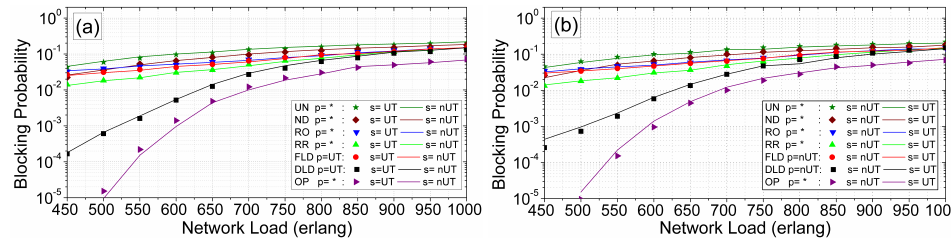
Figure 7. Blocking probability as a function of the total load in EuroNet topology using 504 regenera- tors and traffic: ( a ) uniform and ( b ) non uniform.